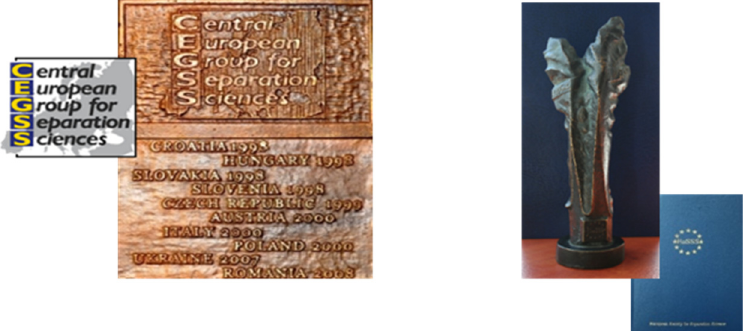
Figure 11. CEGSS medal and Tswiett Nernst statue.